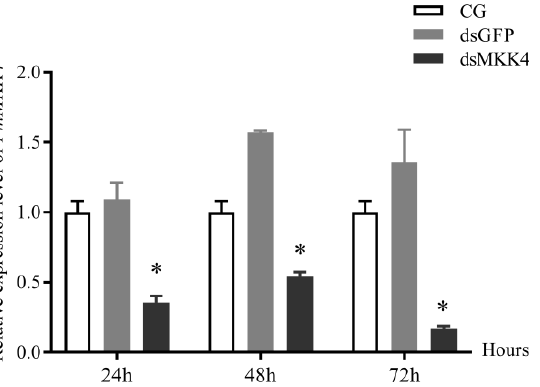
Figure 7. PmMKK4 mRNA expression profiles after silencing by RNA interference. Quantitative RT-PCR was performed to determine the expression of PmMKK4 in gills of P. monodon at different time intervals (n = 3 for each group) after dsRNA injection. Vertical bars represent the mean ± S.E. (n = 3). Significant differences are indicated by * ( p < 0.05).